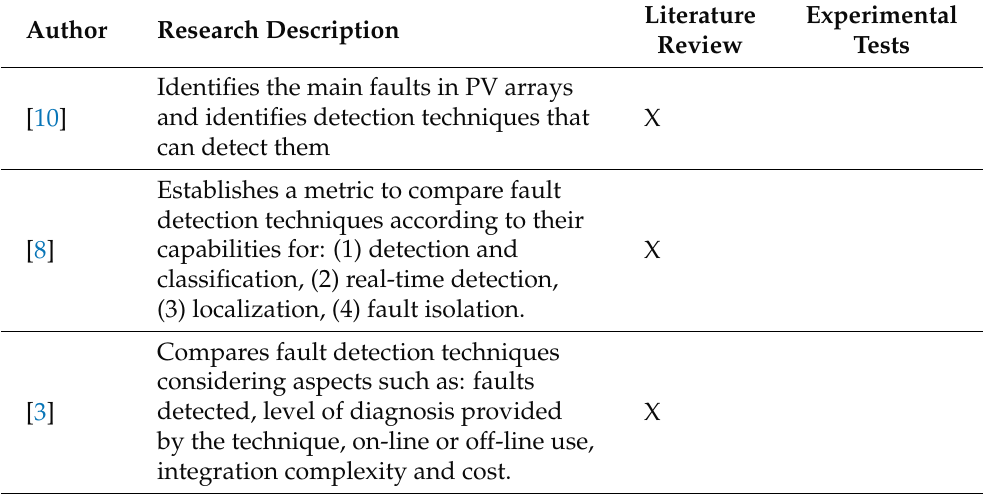
Table 1. Some relevant research related to the characterization or comparison of failure detection